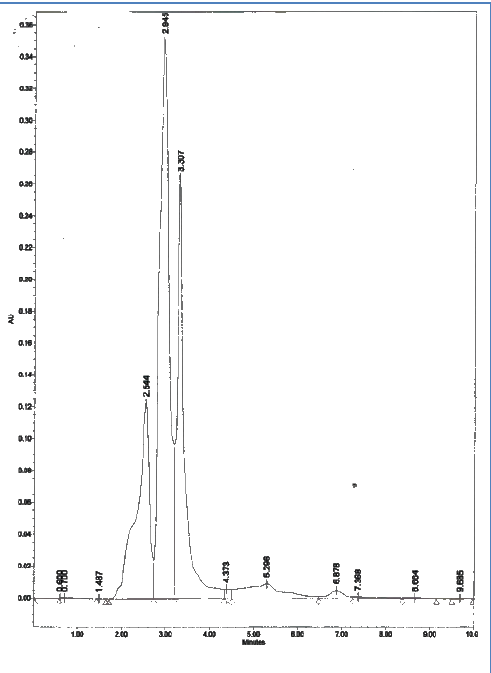
Figure (5):- HPLC of spiking of n-butanol fraction with standard